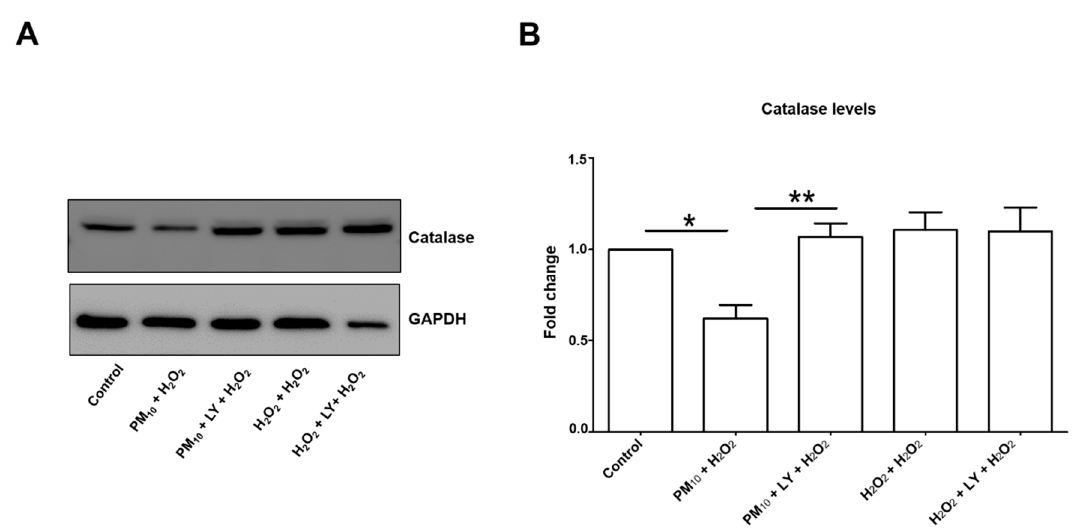
Figure 5. Representative blot of ( A ) assessed catalase levels and ( B ) densitometry using ImageJ software. Lung epithelial cells were pre-exposed to PM 10 (10 µg/cm 2 ) for 24 h, and then cells were treated with H 2 O 2 (500 µM) for 24 h. In lane 3 and 6 of the blot (panel ( A )) are cells treated with LY294002 inhibitor (LY) (50 µM) for 1 h before the H 2 O 2 (500 µM) treatment. Glyceraldehyde 3-phosphate dehydrogenase (GAPDH) protein was used as loading control for western blot. * p < 0.001 versus control; ** p < 0.01 versus PM 10 + H 2 O 2 . The image is representative of three independent experiments, and values are the mean ± SD of three independent experiments.